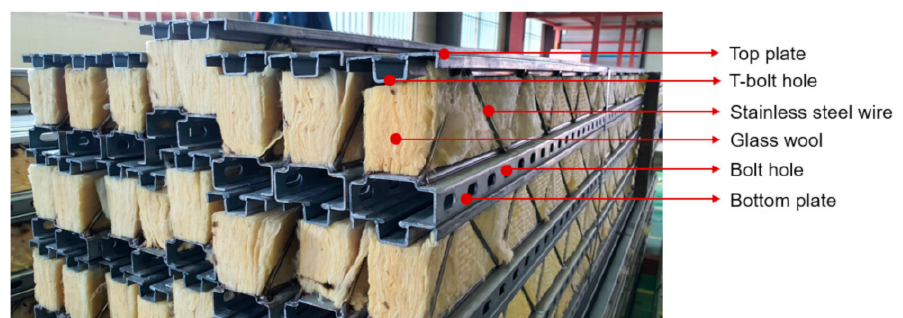
Figure 3. Configuration of the truss-shaped insulation frame (TIF).